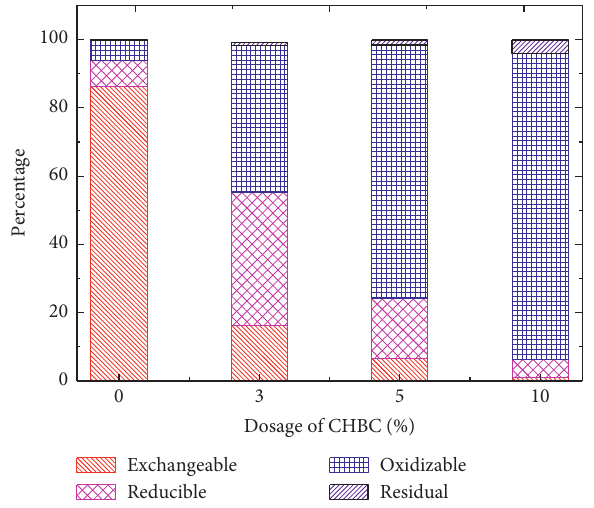
Figure 7: Effect of CHBC dosage on speciation distribution of Cr of stabilized